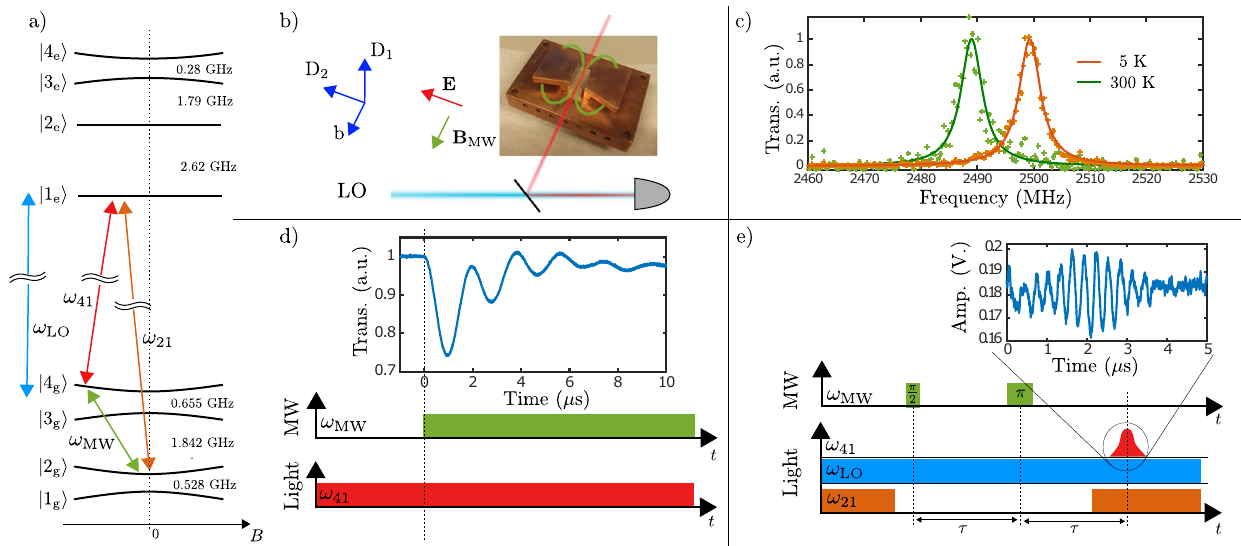
Fig. 1 Experimental setup. a Energy level diagram for the optical 2 F 7/2 (0) ↔ 2 F 5/2 (0) transition of site II in 171 Yb 3 + :Y 2 SiO 5 , with relevant optical and MW transition used in the experiments. b Picture of the loop-gap resonator and the crystal illustrating the common volume excited by the laser E and microwave B MW fi elds, aligned along the D 2 and b crystal axes, respectively. c MW transmission spectra recorded through the resonator at 5 K and 300 K. d Rabi oscillation time sequence, see text for details, with an example of laser power transmission showing the Rabi oscillations. e MW Hahn echo time sequence, see text for details. The inset shows an example of the optical RHS echo signal, detected through balanced heterodyne detection at a beat frequency of 3